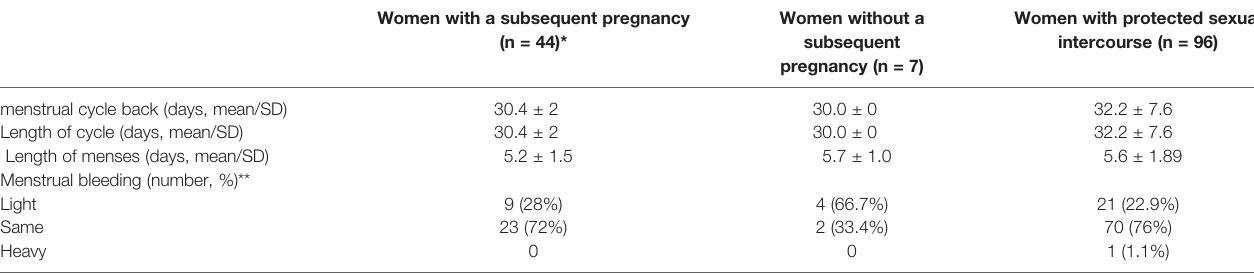
TABLE 2 | Information on menstrual cycle in women with or without a subsequent pregnancy after an initial treatment of caesarean scar